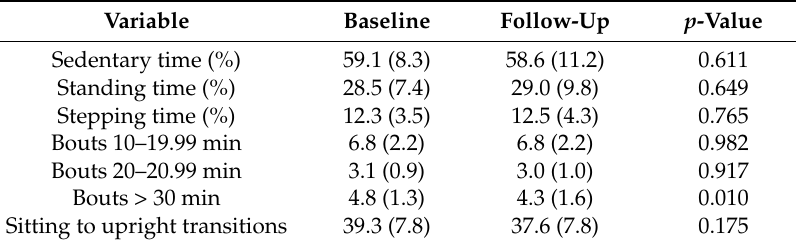
Table 3. Intervention outcomes whole